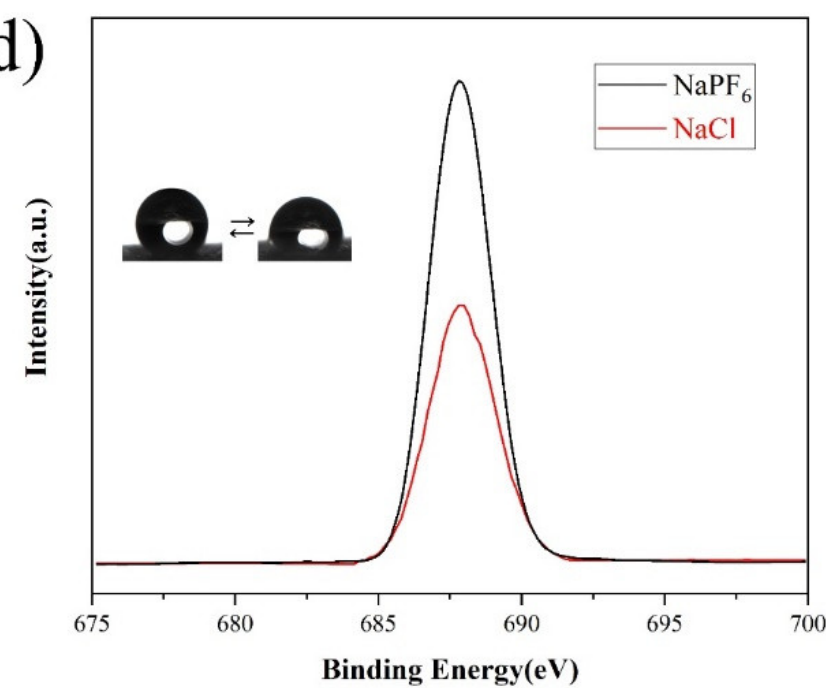
Figure 7. XPS spectra of F element on the surface of anions dispersed on paper treated with different solvents ( a ) Acetone; ( b ) Water/methanol ( v / v : 1/1); ( c ) Methanol; ( d ) Water.